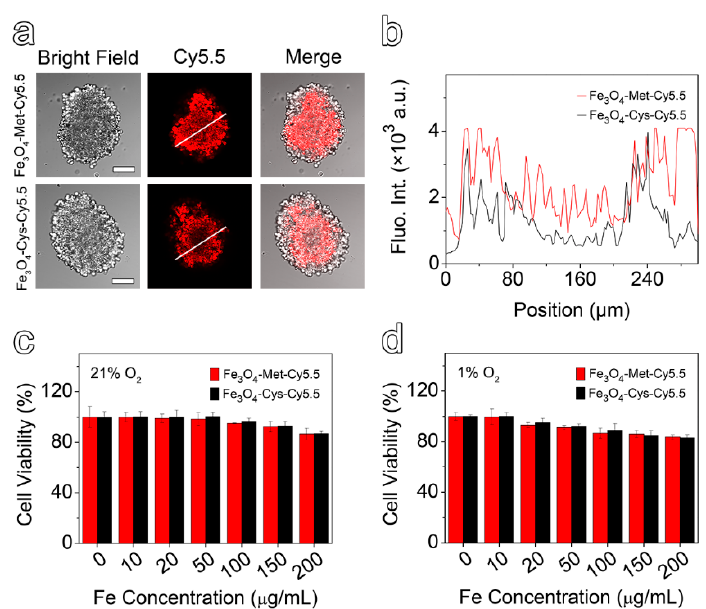
Figure 3. ( a ) The bright field and fluorescence images of multicellular spheres in the profile of 50 µ m from the maximum cross-section (scale bar represents 100 μ m). ( b ) The relative fluorescence intensity distribution, along with the white line drawn on the fluorescence images. MCF-7 cells viabilities by CCK-8 assay after incubating with varied concentrations of Fe 3 O 4 -Cys-Cy5.5 or Fe 3 O 4 -Met-Cy5.5 under 21% ( c ) and 1% O 2 ( d ).